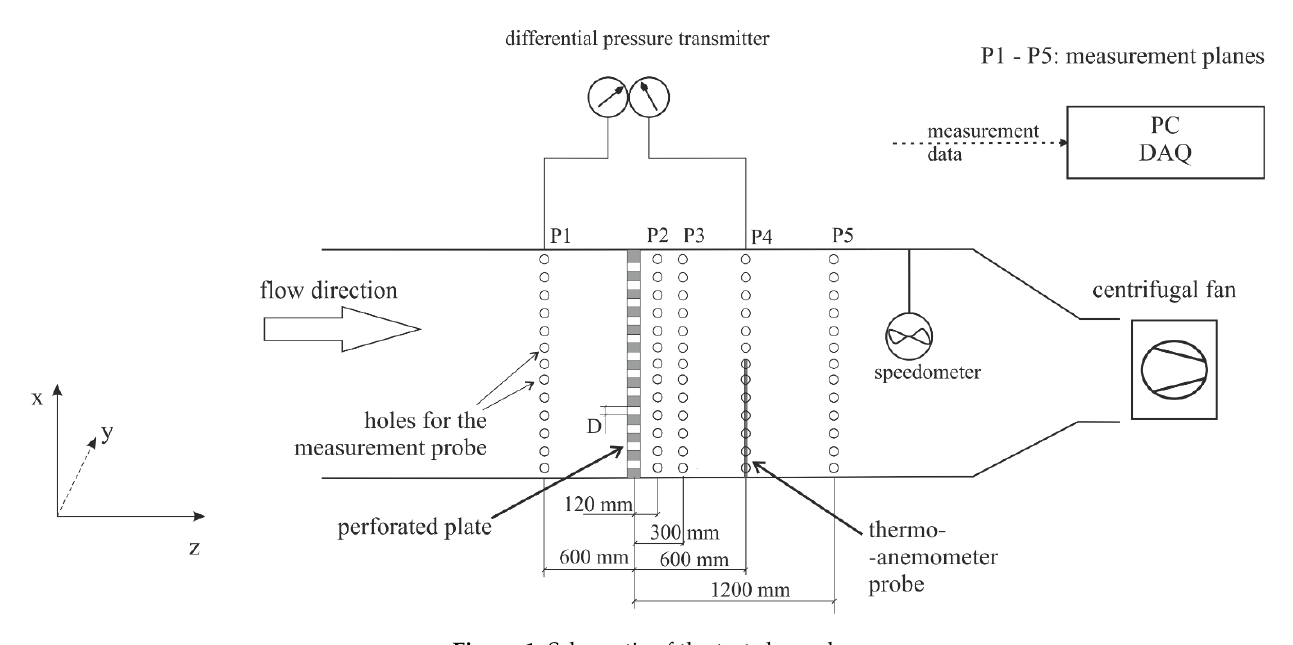
Figure 1. Schematic of the test channel.